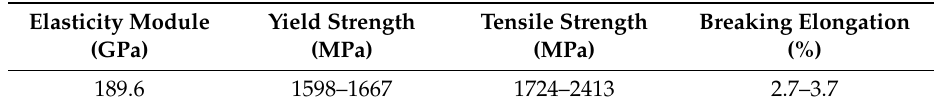
Table 3. Mechanical properties of Elgiloy.